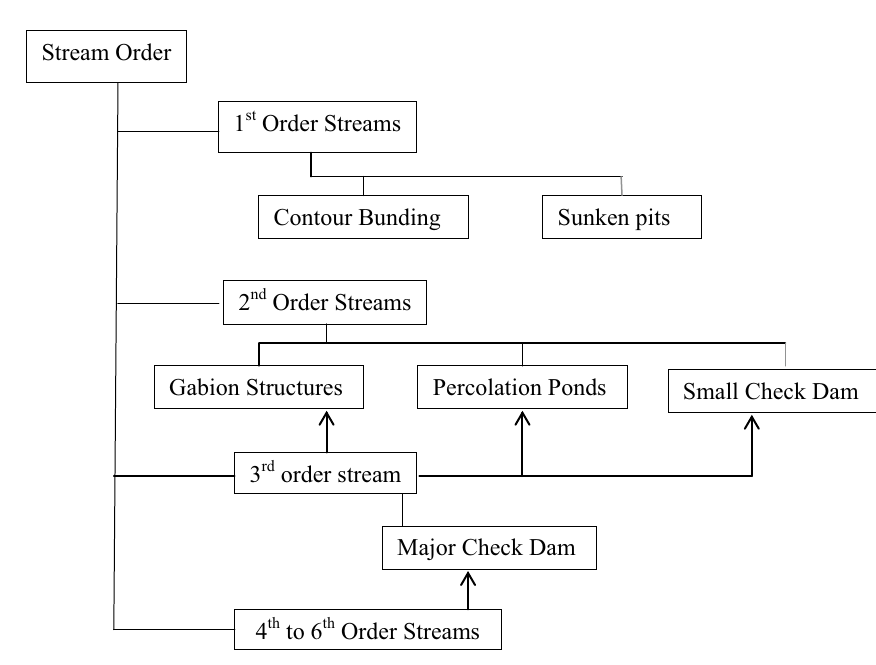
Fig. 14 Decision support model (DSM) based on based on stream